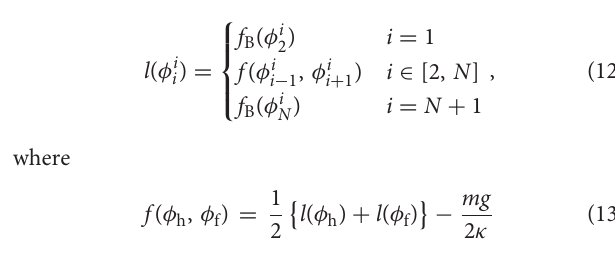
FIGURE 8 | Assumptions for the phases of the neighboring legs at each touchdown event for the source-wave